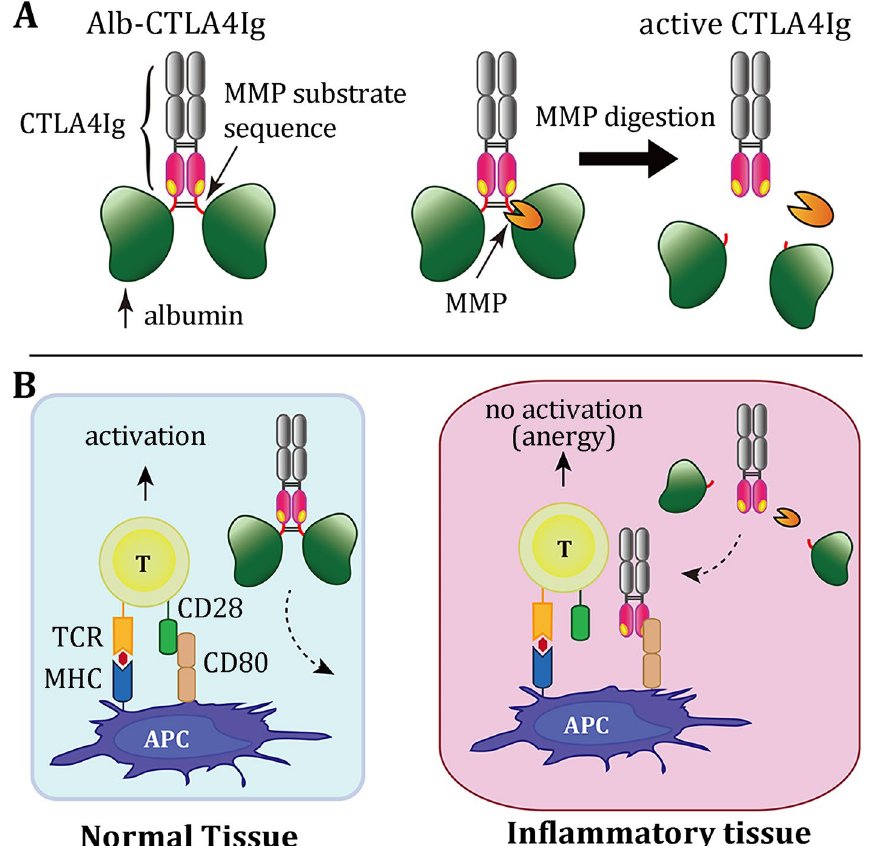
Fig. 1 The strategy to develop a lesion‑selective Alb‑CTLA‑4Ig for the treatment of collagen‑induced arthritis. A Albumin is linked (via a hinge sequence) to the N‑terminus of CTLA4Ig to mask its binding sites to CD80. Albumin can be removed by MMP digestion at the hinge sequence to restore the binding activity. B When Alb‑CTLA4Ig circulates through normal tissues (left), it is inactive due to the low expression of MMPs. However, Alb‑CTLA4Ig is converted to an active form (CTLA4Ig) when it enters the inflammatory tissues where MMPs are selectively overexpressed. The activated form can bind to CD80 or CD86 to block the second signal required for full T cell